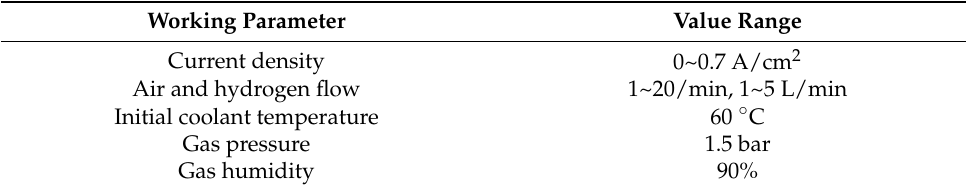
Figure 5. Fuel cell control strategy model diagram. Table 2. Fuel cell Working parameters